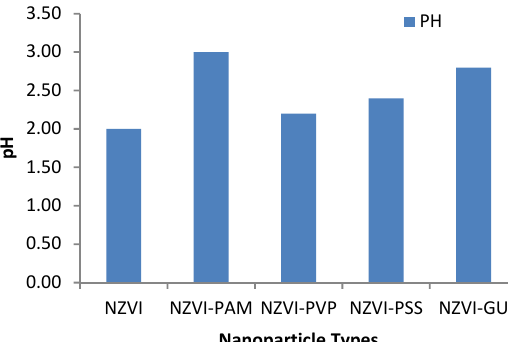
Fig.15. Optimum pH values for Cr(VI) removal from solutions using bare and different polymer stabilized